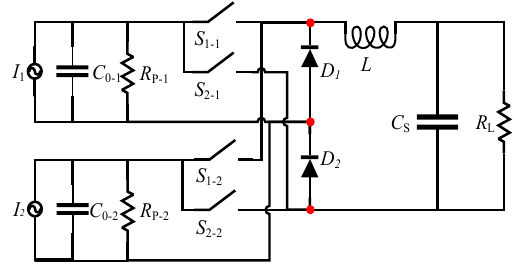
Figure 8. Figure 8. MSI-SECE.